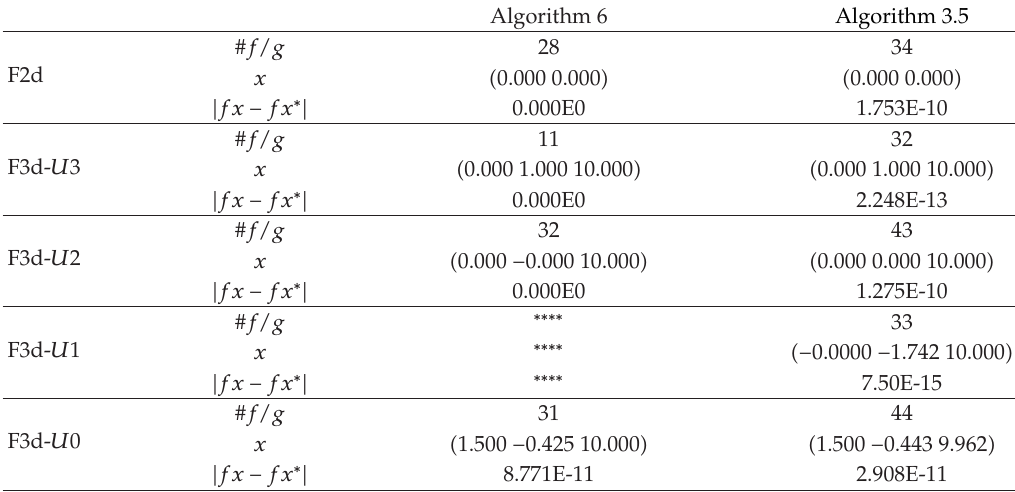
Table 2: Numerical results of UV-decomposition algorithm with inexact data. Algorithm 6 Algorithm